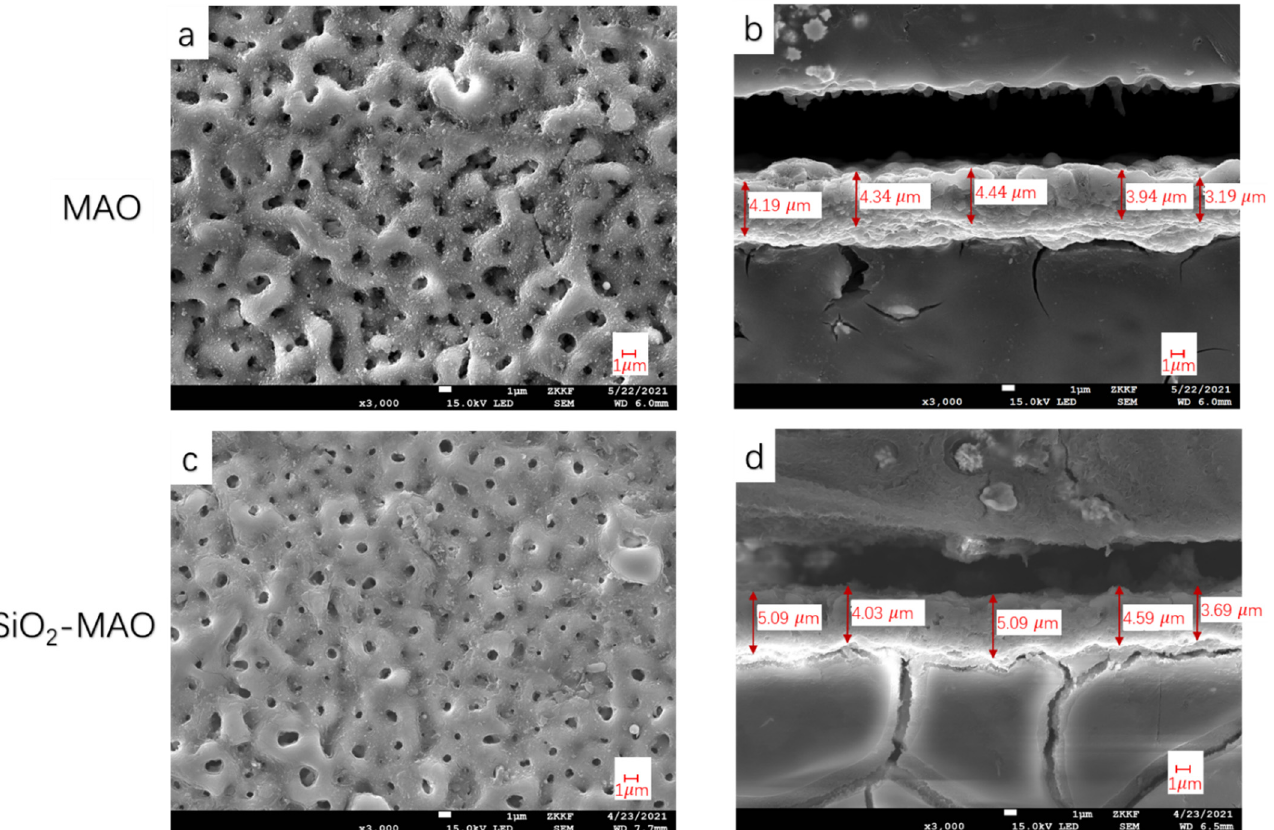
Figure 1. Micromorphology of coatings, ( a , b ) Surface and cross-section morphology of the MAO coating, ( c , d ) Surface and cross-section morphology of the SiO 2 /MAO coating.